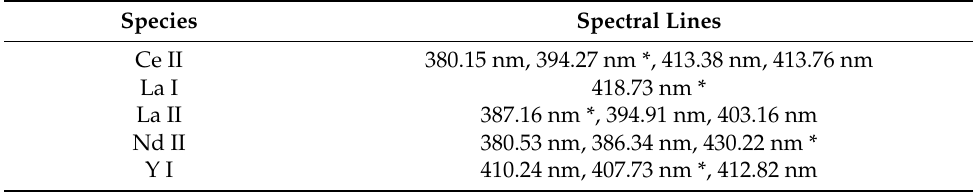
Table 1. Experimental spectral lines of analyzed REE (shown in Figure 2b) used in this work collected with the echelle spectrometer. Emission wavelengths marked with an asterisk (*) are not used in this